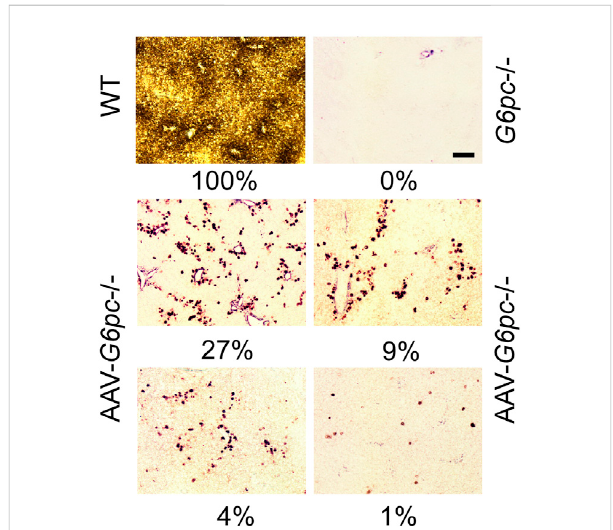
FIGURE 7 Histochemical analysis of hepatic G6Pase- α activity in WT, G6pc − / − , and G6pc − / − mice treated with rAAV-G6PC-S298C (AAV- G6pc − / − ) (Zhang et al., 2020). Liver samples from control and rAAV- G6PC-S298C-treated mice were collected at sacri fi ce following 12 or 24 h of fast. In WT mice, G6Pase- α was distributed throughout the liver with signi fi cantly higher levels in proximity to blood vessels. The numbers in percentage represent hepatic microsomal G6Pase- α activity restored in the AAV- G6pc − / − mice. Scale bar = 20